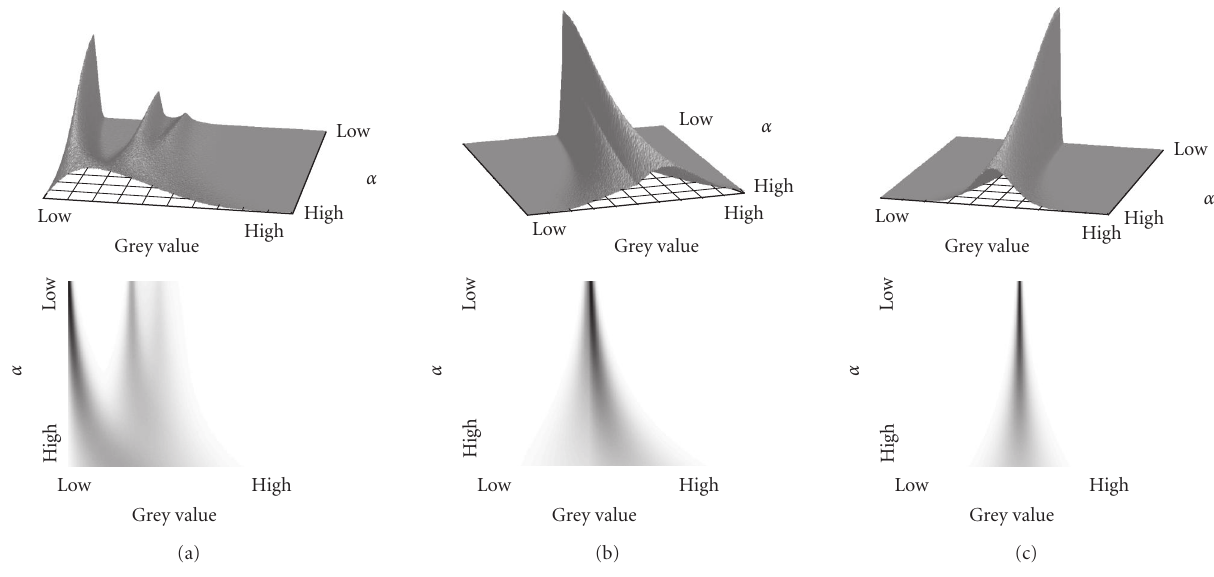
Figure 4: (a) Histogram of a noisy MR image, (b) histogram of the di ff erence between a noisy MR image and the noise-free MR image, and (c) histogram of the di ff erence of two noisy MR images, for various σ . Top: surface plots, bottom: grey-value maps.